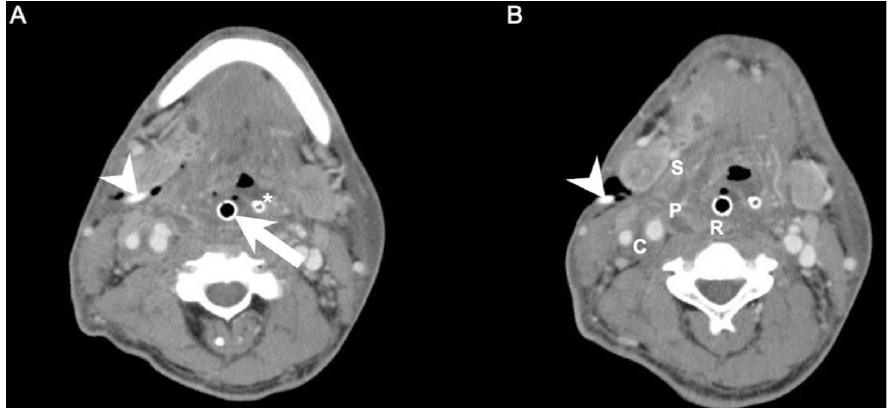
Figure 1. ( A , B ). Axial views of a patient who required repeat I&D. Arrowhead: drainage tube of the first surgery; Arrow: endotracheal tube; Asterisk: nasogastric tube; C: carotid space; P: parapharyngeal space; R: retropharyngeal space; S: submandibular space.